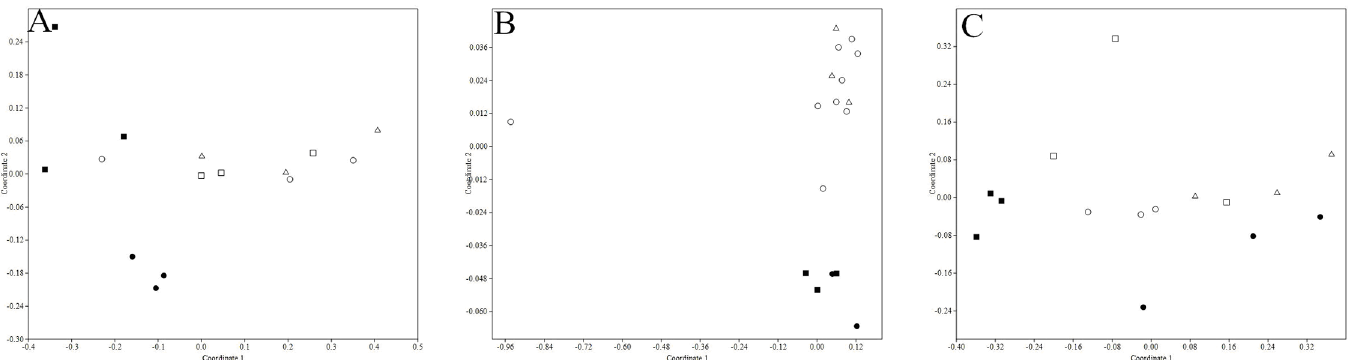
Fig 4. Distribution characteristics of ARGs in soils of cattle farms (A), poultry farms (B) and porcine farms (C) located in five different regions. ( (cid:1) : SQ ● : CZ □ : HA ■ : NJ 4 : XZ)(Bray-Curtis similarity coefficients were calculated from absolute abundance of ARGs and plotted in a multidimensional scaling graph. The distance between points indicates the degree of difference in the diversity of ARGs between samples)